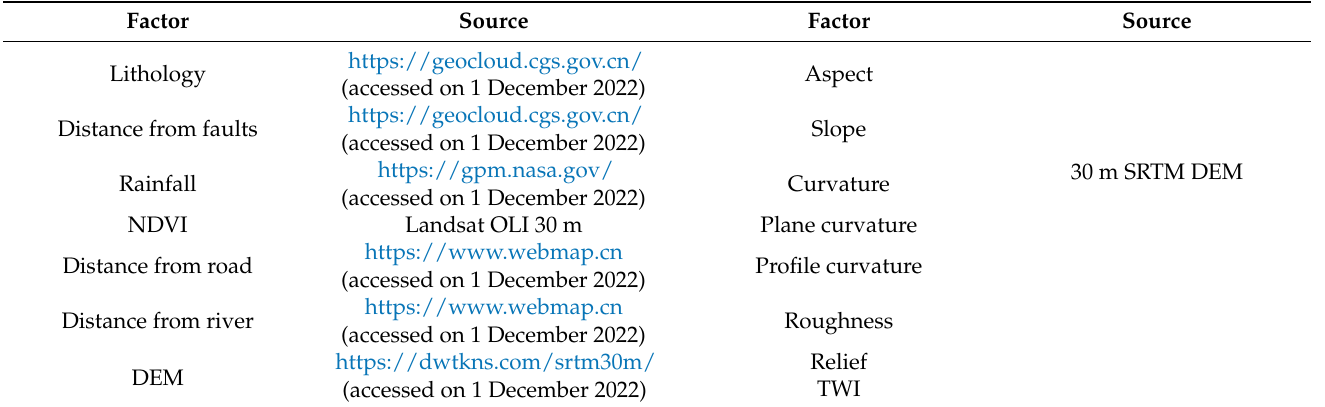
Table 1. Factors and their sources.